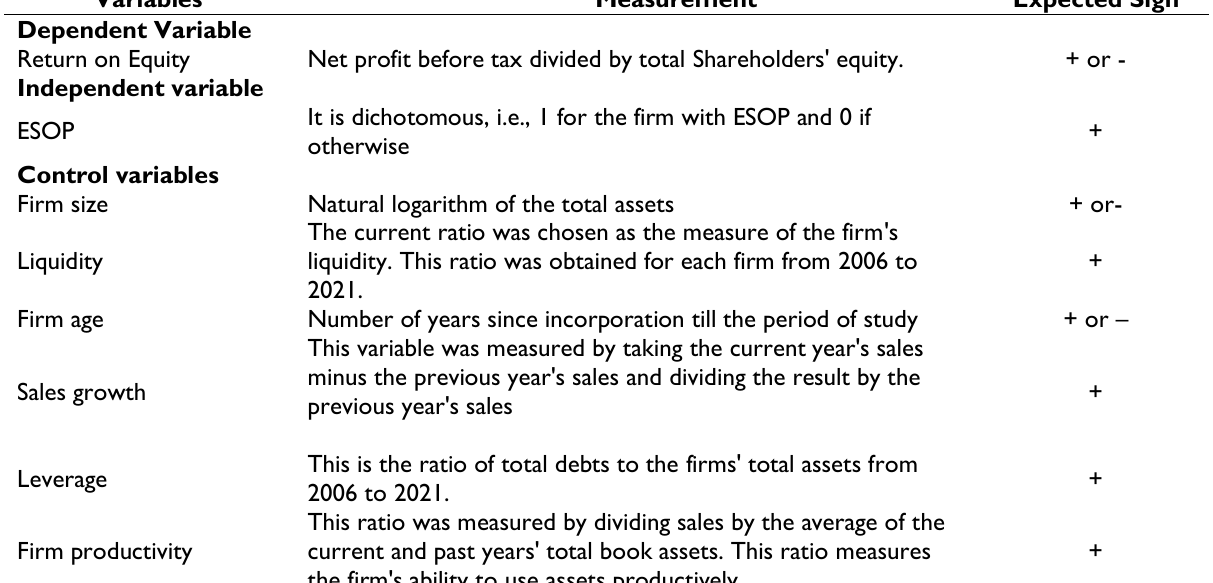
Table 1: Variables Measurement Variables